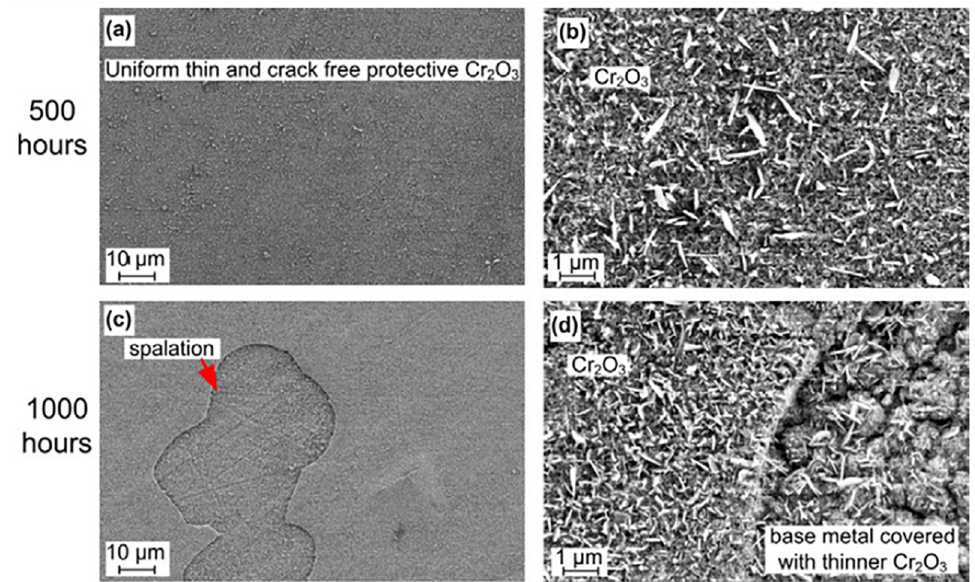
Figure 8. Surface oxide morphology of alloy 625 samples exposed to S-CO 2 at 650 °C/20 MPa for ( a , b ) 500 h, ( c , d ) 1000 h [46]. Reproduced with permission from Elsevier.